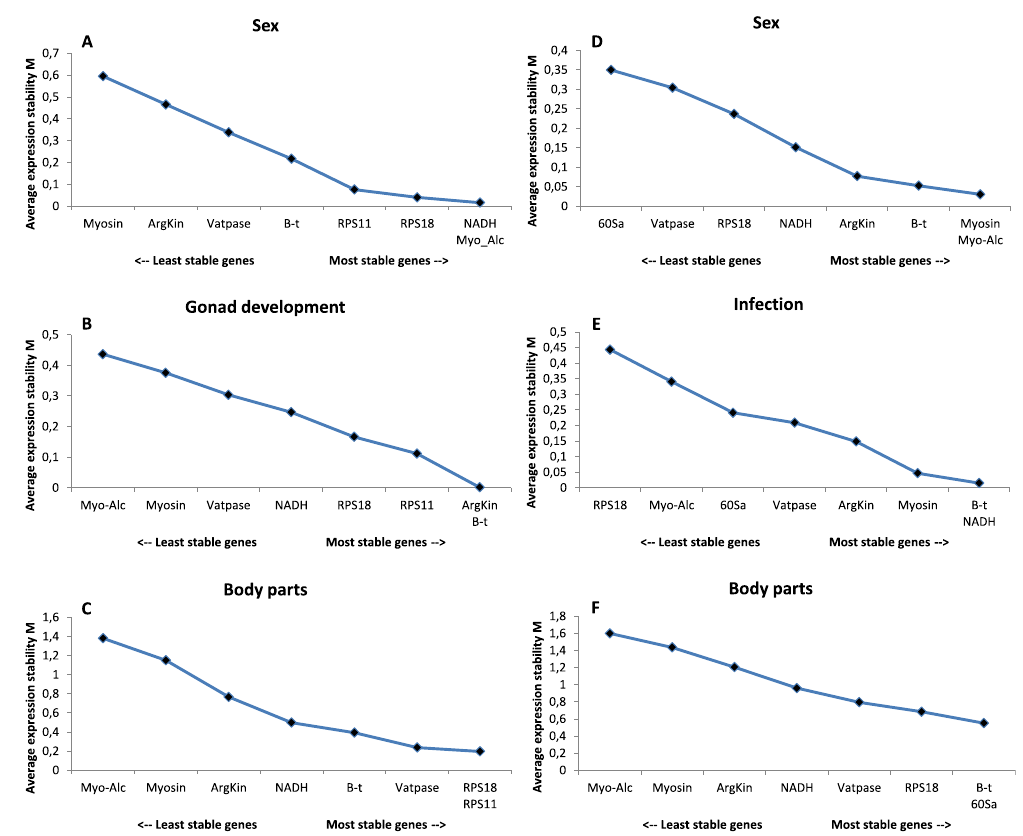
Figure 5. Average stability values (M) of remaining reference genes during stepwise exclusion for Cicindela campestris ( A–C ) and Calomera littoralis ( D–F ). Analysis was performed by geNorm for all conditions